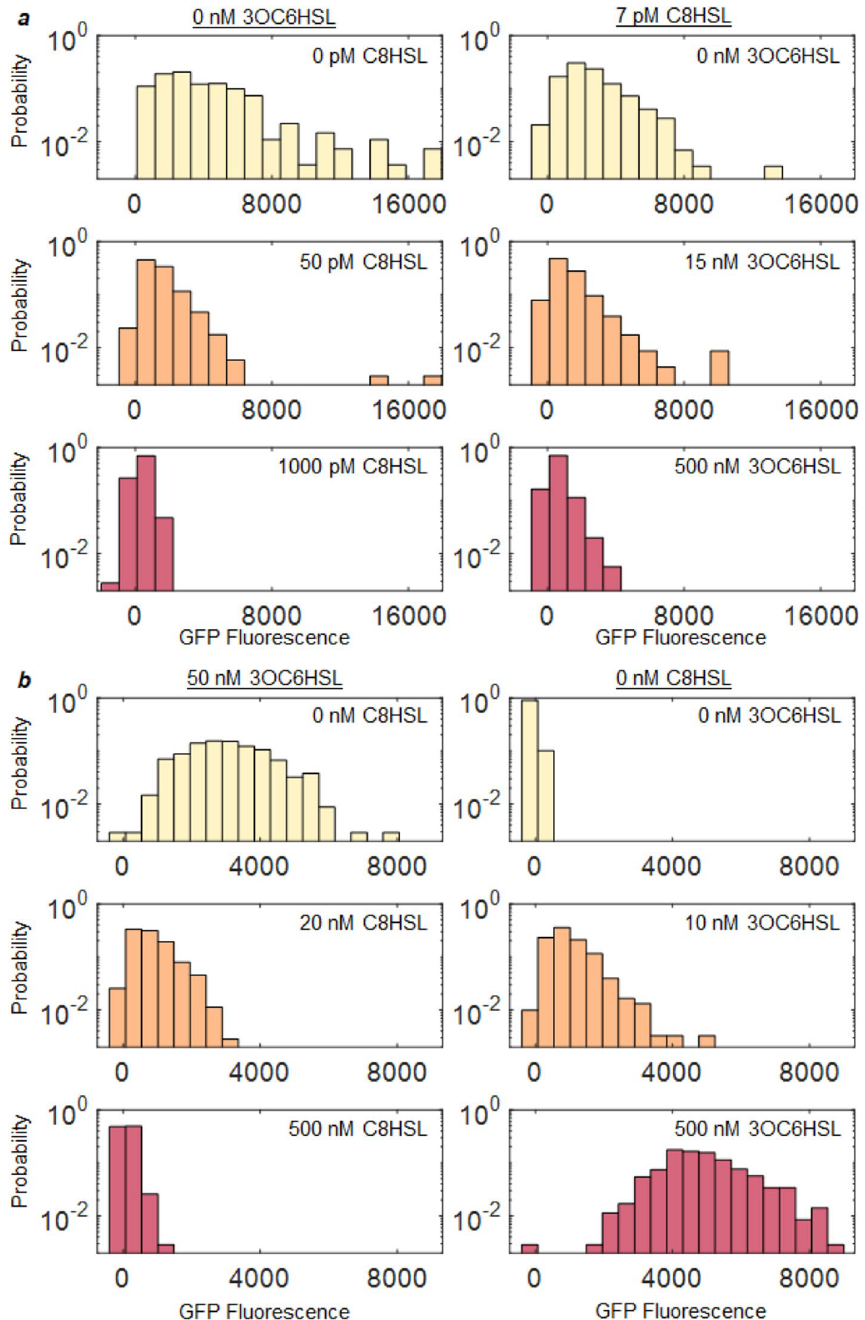
Figure 3. Combinations of HSL inputs shift the statistical distribution of P qrr and P lux activity in a population of V. fischeri . (a) Activity of qrr reporter measured in individual cells at different C8HSL concentrations with 3OC6HSL held fixed (left panels) or C8HSL fixed (right panels). (b) Activity of lux reporter at different C8HSL concentrations with 3OC6HSL held fixed (left panels) and C8HSL fixed (right panels). Each histogram summarizes the GFP reporter fluorescence measured for ~ 400 individual